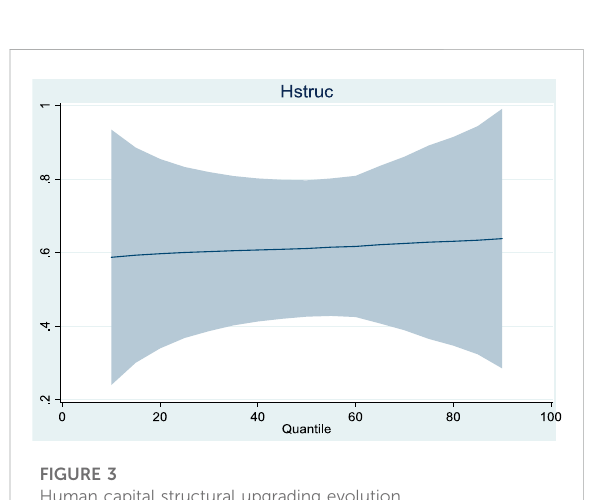
FIGURE 2 Business environment evolution.